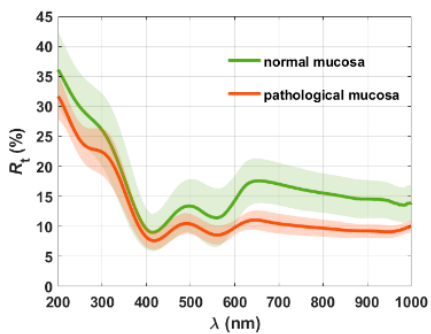
Figure 5. Mean R t spectra of the normal and pathological mucosa.